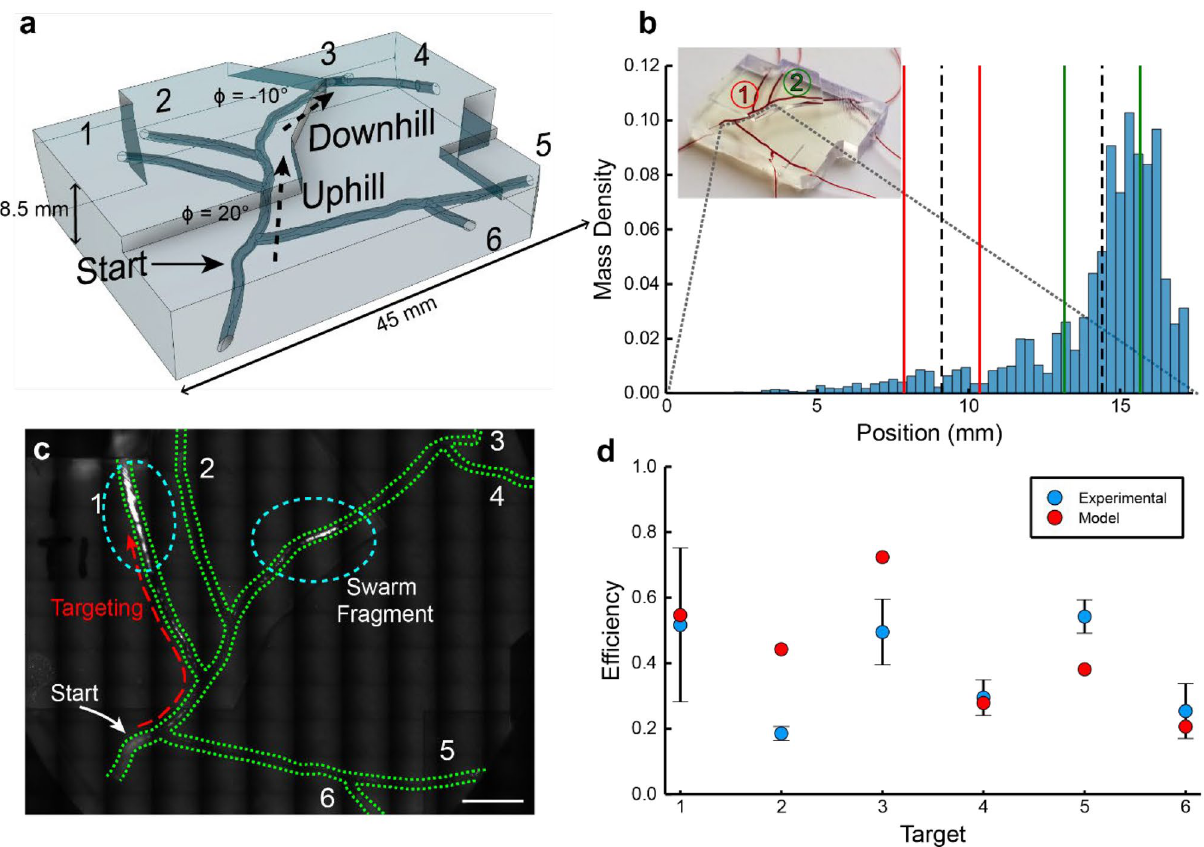
Figure 5. µWheel swarm targeting. ( a ) CAD model of branching 3D vascular model. Each branch is labeled 1–6. Image created using Fusion 360 (Autodesk). ( b ) µWheel mass density histogram of rolling swarm simulated ~ 14 mm into the device. Dotted lines signify the locations of the center of branches 1 and 2, while the bordering solid lines select which µwheels are captured in each branch. ( c ) Fluorescence scan after targeting µwheel swarm to branch 1, annotated with Illustrator (Adobe). Scale = 5 mm. ( d ) Experimental and modelled targeting efficiency of rolling µwheel swarm. ( b , d ) created using Julia v1.6.1 (https:// doi. org/ 10. 1137/ 14100 0671), annotated with Illustrator